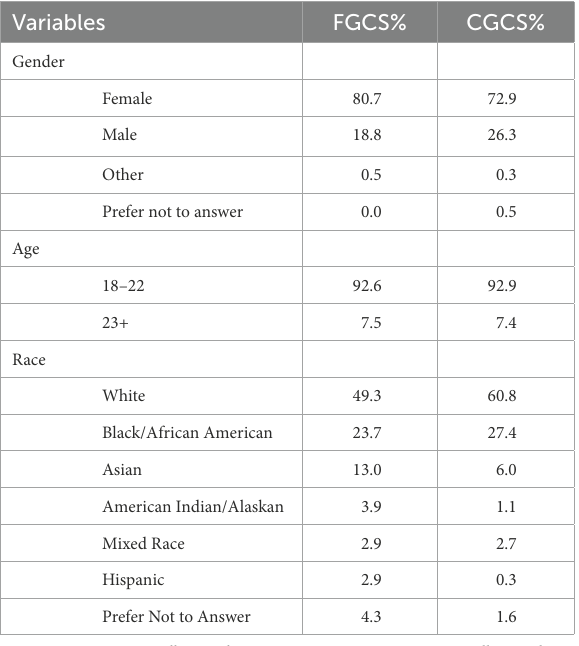
TABLE 1 Demographic information by generation